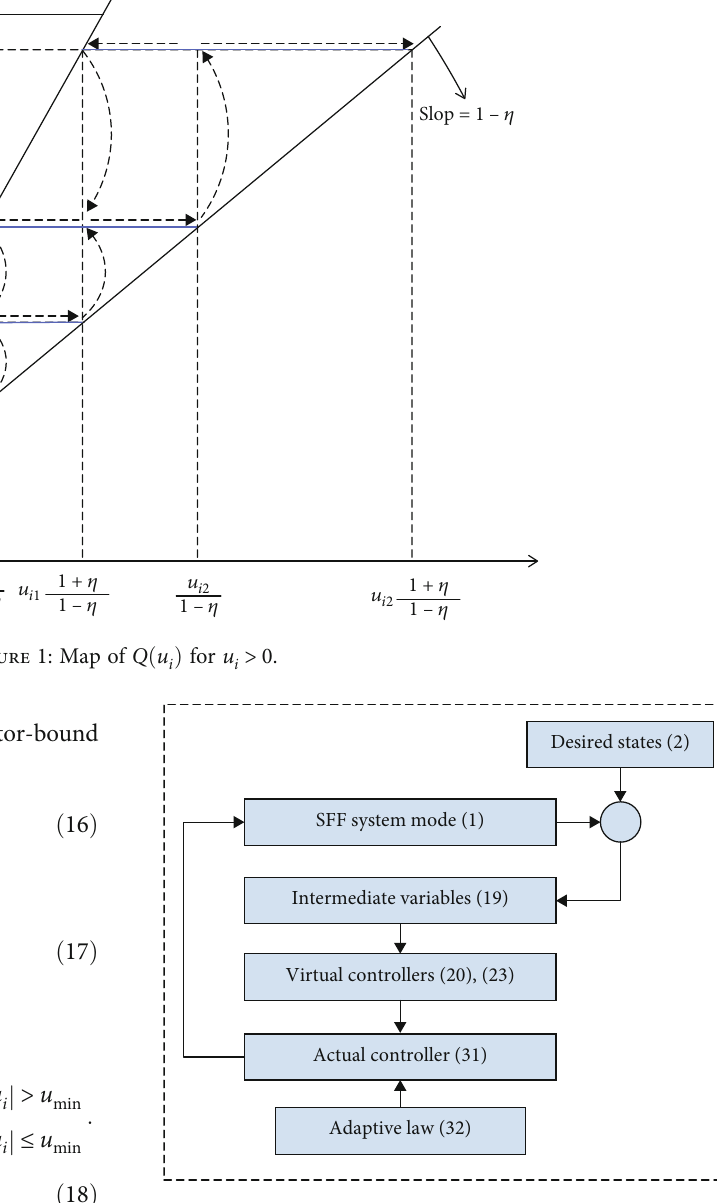
Figure 2: Block diagram of the fi nite-time control